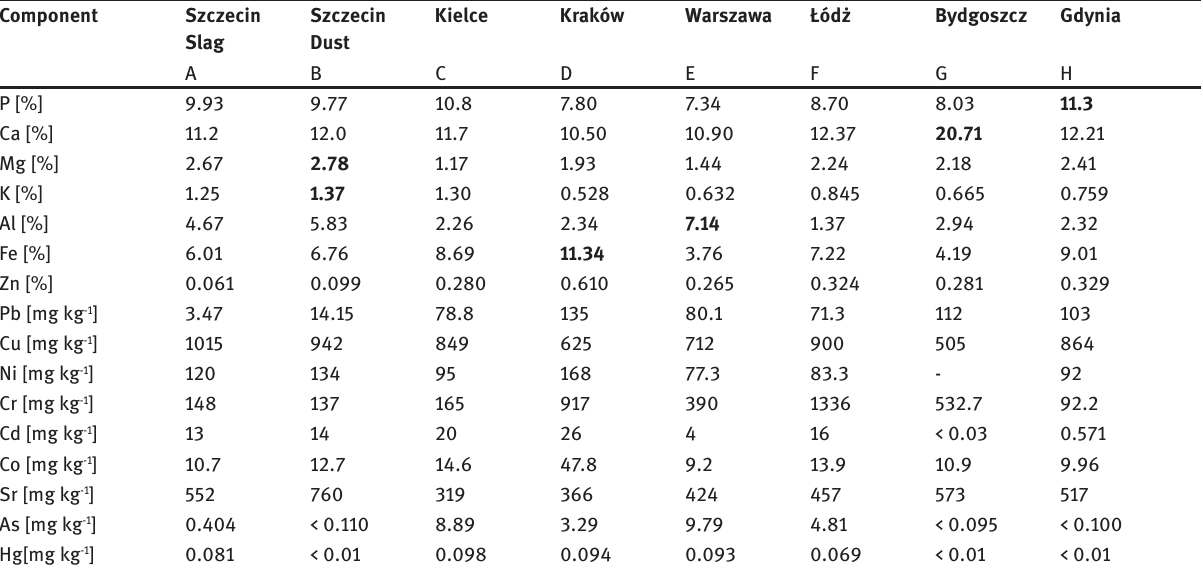
Table 2: The chemical composition of SSA.